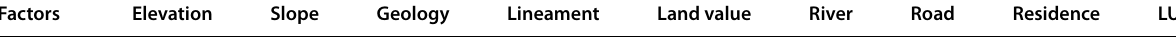
Table 3 Collinearity statistics of Land fill suitable site selection parameters Factors